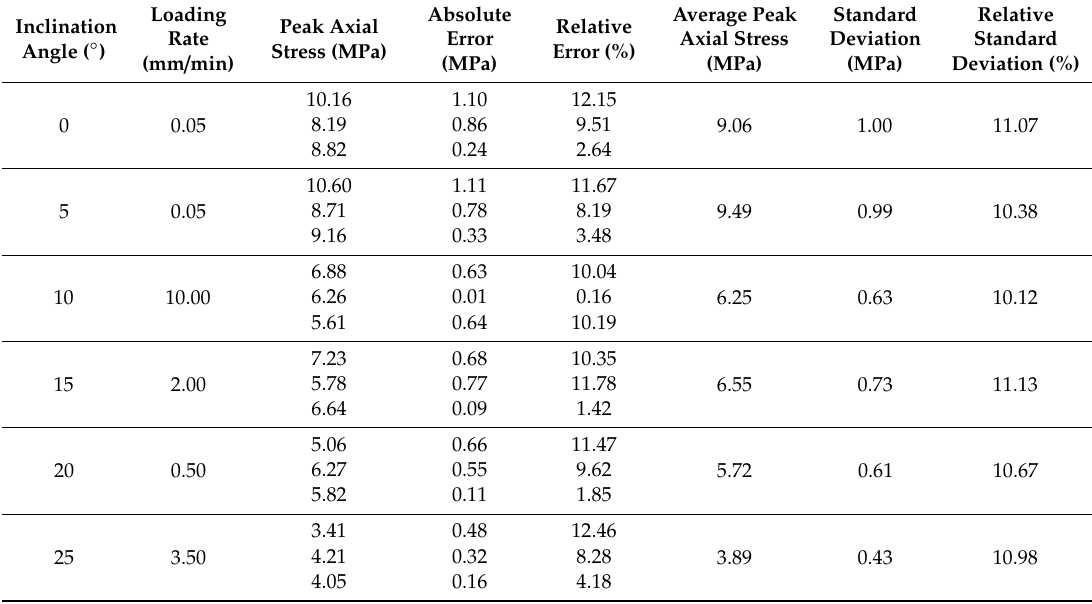
Table 2. Peak axial stress varies with the loading rate and inclination